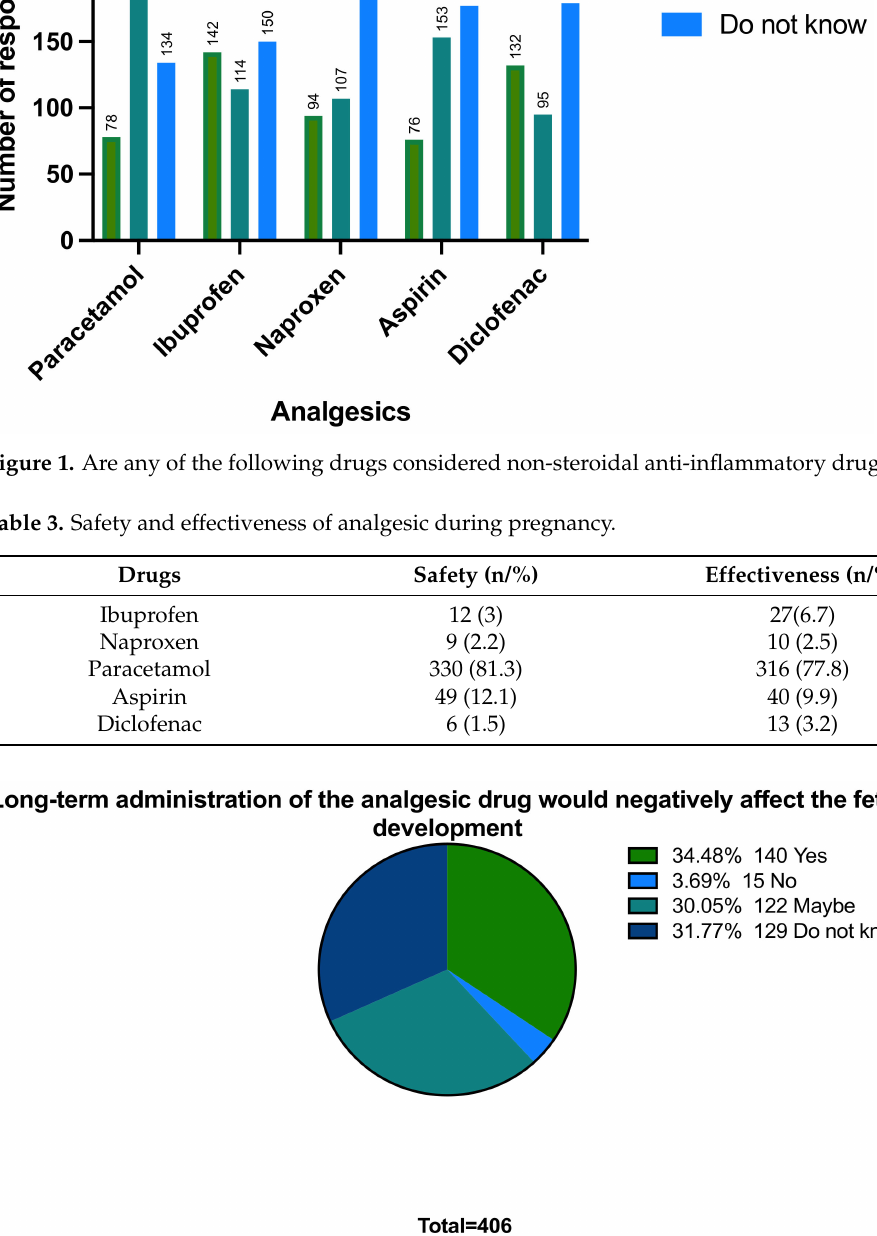
Figure 2. Long-term administration of the analgesic drug would negatively affect the fetal